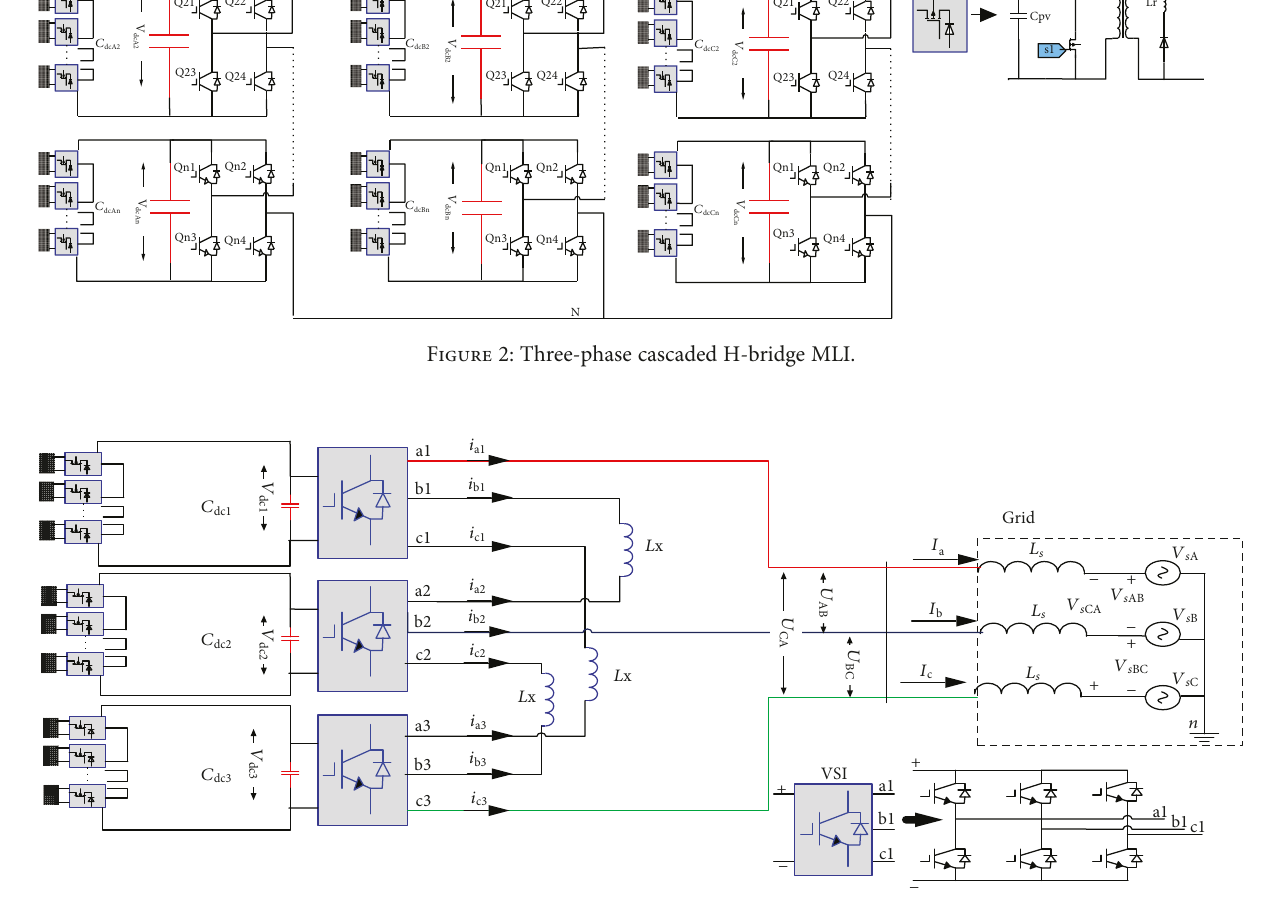
Figure 3: Three-phase cascaded VSI using inductors.